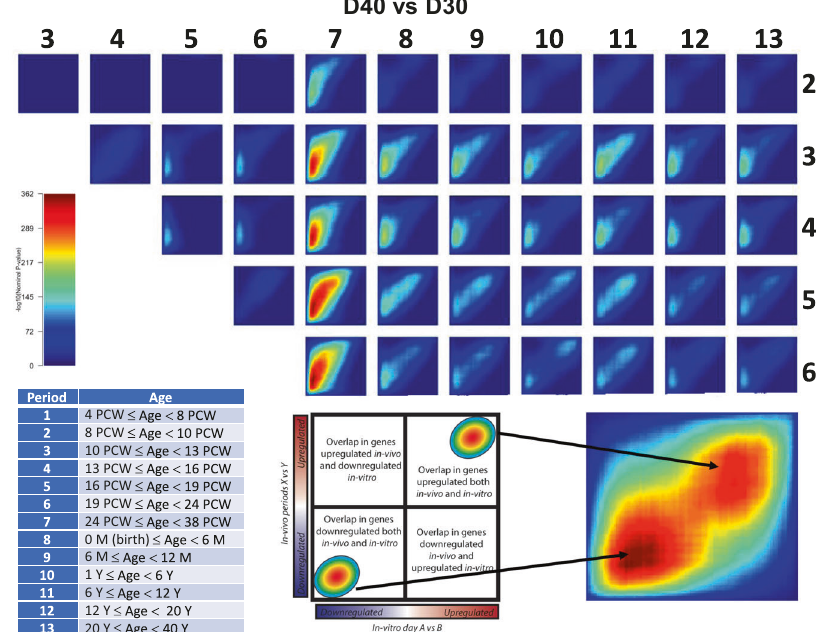
Fig. 3 In vitro gene expression pro fi les correspond to in vivo cortical fetal development. Transition mapping output showing the degree of overlap between the in vitro transition from day 30 to day 40 (astrocytes) and in vivo transitions between successive periods of cortical development. The maps are colored by − log10( p -value). Strongest overlap was observed with in vivo transitions to period 7 (24 PCW to 38 PCW), involving mostly downregulated genes in both in vitro and in vivo transitions. PCW post conception week, M month, Y